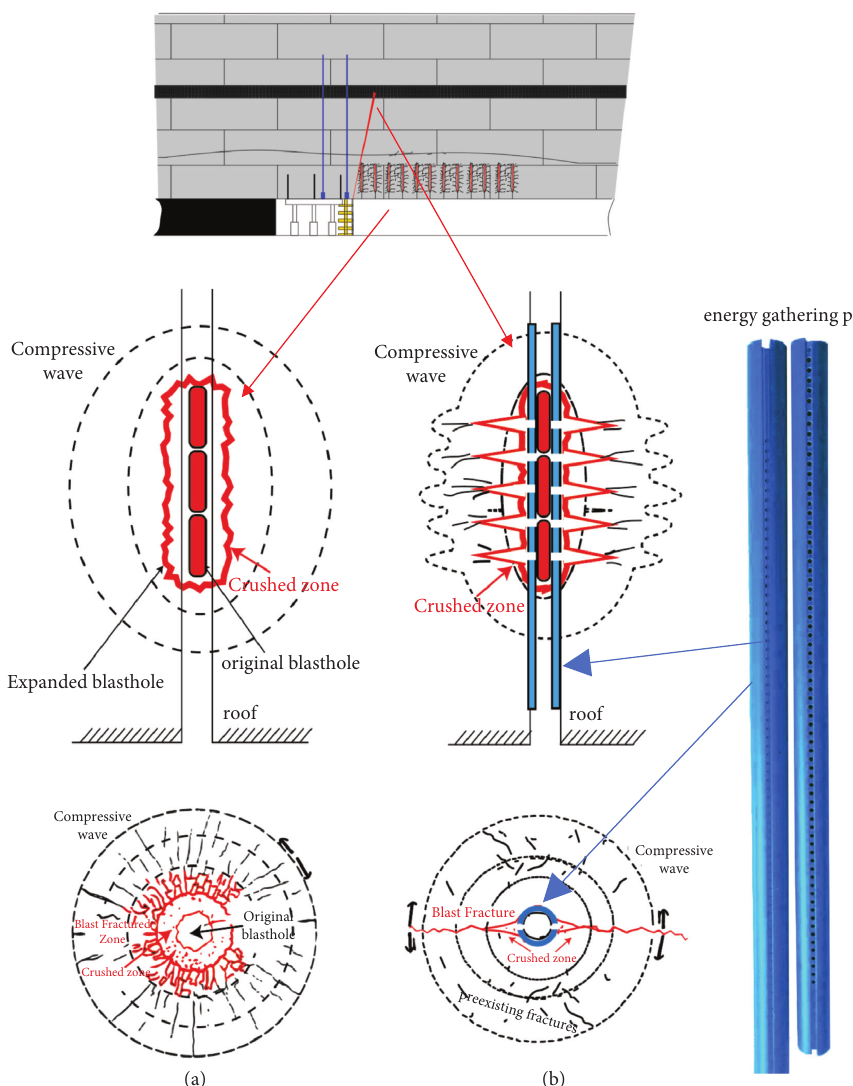
Figure 4: Principle of integrated presplitting technology. (a) Fragmentation blasting. The shallow hole blasting is to fragmented regional roof, which is to create cracks in the roof and weaken the strength of the roof, and reduce the span of the roof and the pressure when it collapses. (b) Directional cutting roof blasting. This roof-cutting blasting uses special PVC pipes (energy gathering pipe) to form a di- rectional cutting surface, and the result of cutting the roof can be realized.